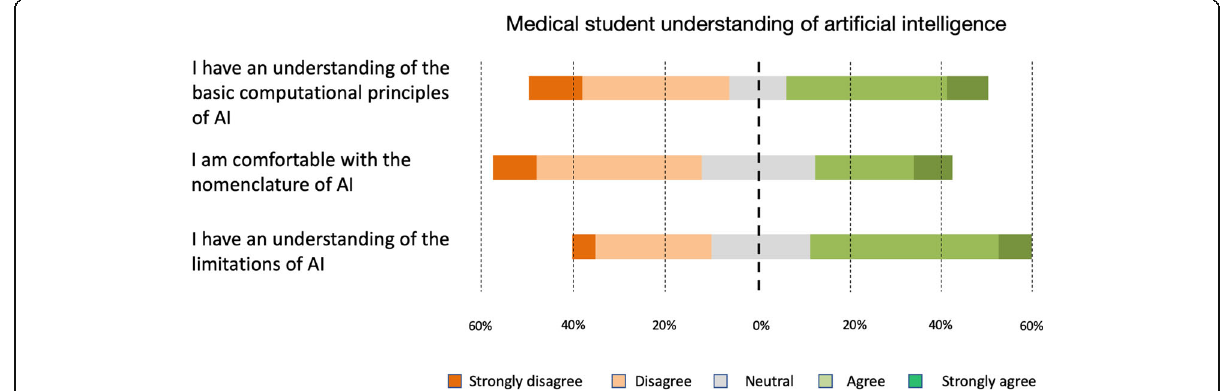
Fig. 2 Summary of questions relating to medical student understanding of AI